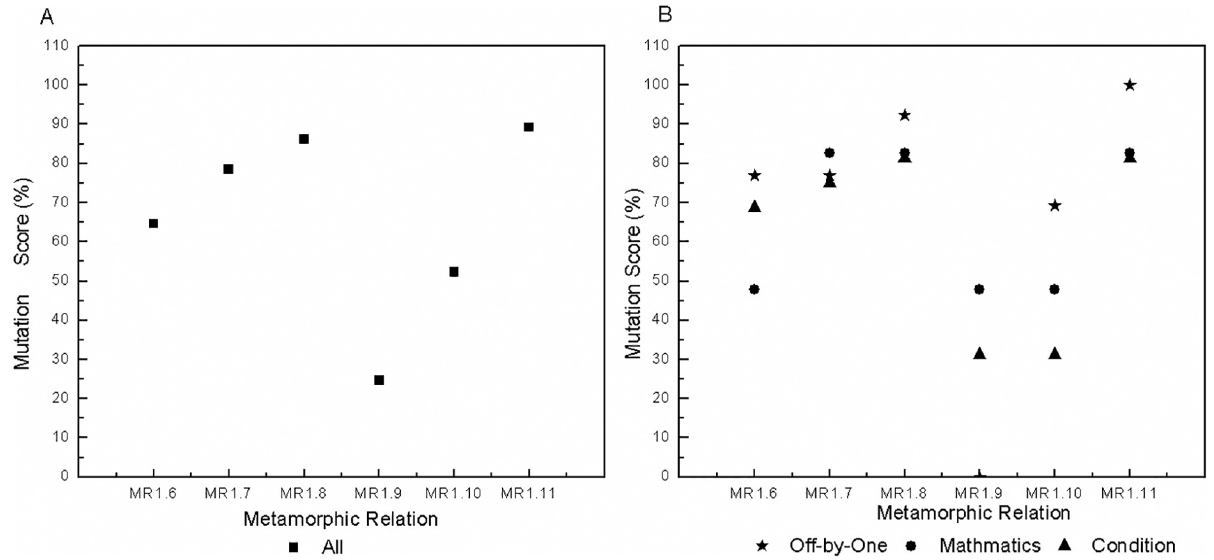
Fig 10. Mutation scores of the MRs based on the same event sequence h ATM withdrawal,ATM withdrawal i . A: Those for all mutants. B: Those for different types of mutants.